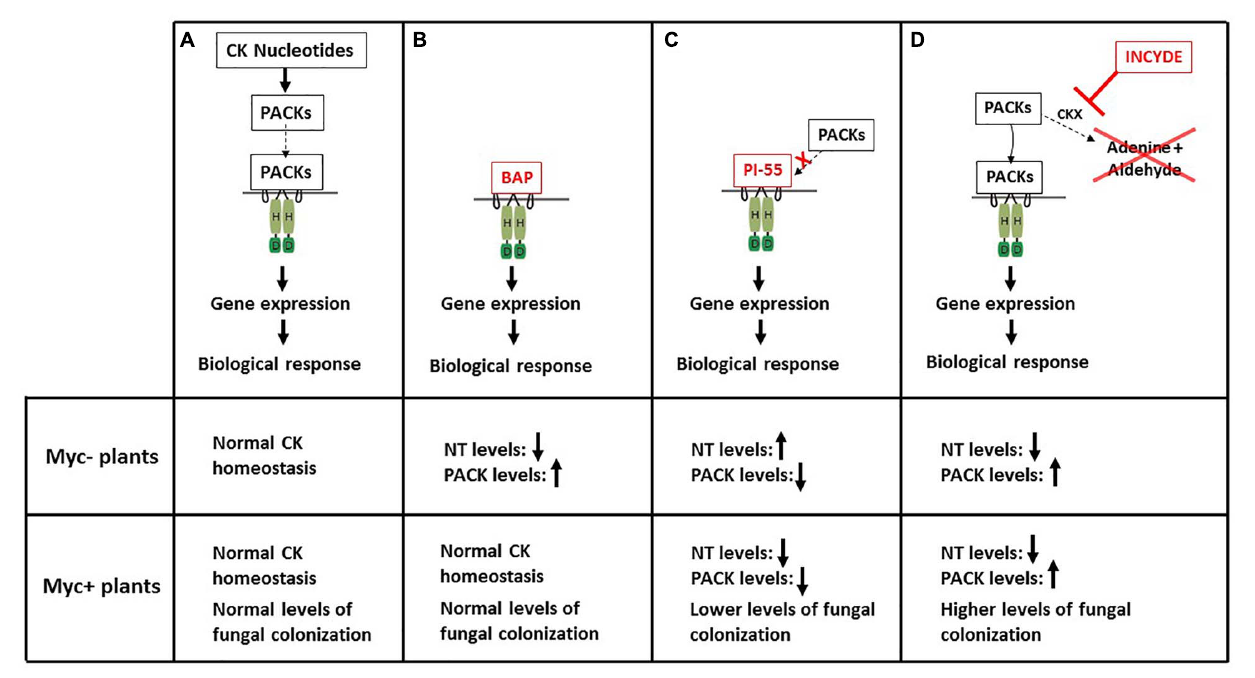
FIGURE 8 | Schematic diagram representing both the perception and the signal transduction pathway of CK in myc − and myc + plants that were either untreated (A) , treated with the cytokinin BAP (B) , the competitive inhibitor of CK action PI-55 (C) , or the inhibitor of CK degradation INCYDE (D) . Upon treatment with the synthetic compounds, levels of NTs and of putatively active CKs (PACKs, comprised of both CK ribosides and CK free bases) are altered. An arrow oriented upward corresponds to an increase in CK levels, whereas an arrow facing downward represents a decrease in CK levels. Higher PACK levels correspond to higher AM colonization whereas lower PACK levels are related to lower AM